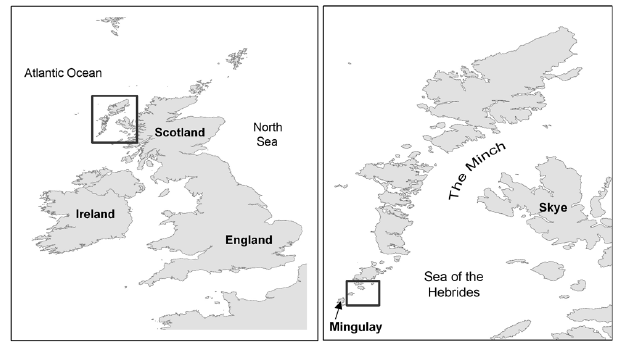
Fig. 1. Regional setting of the Mingulay Reef Complex in the Sea of the Hebrides, western